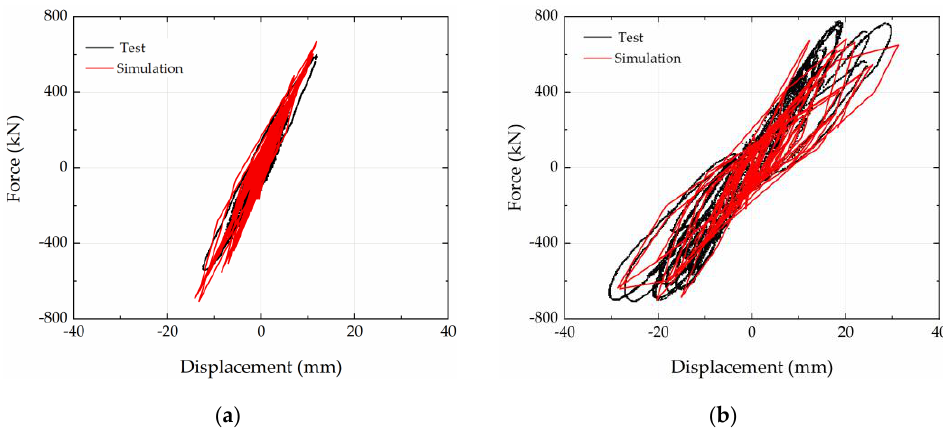
Figure 5. Base shear force-top displacement curves: ( a ) Tar6 case; ( b ) Duz7 case.